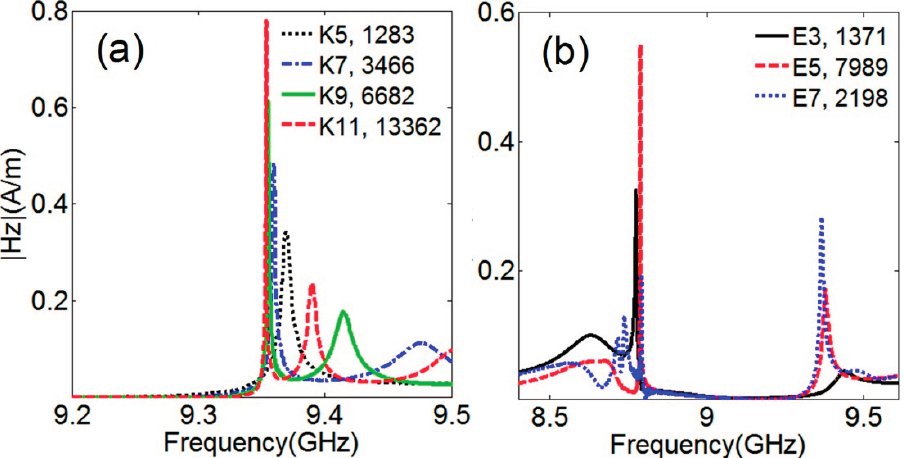
Figure 8. Fano resonances in ( a ) infinite in E-field direction arrays composed of the number of PRAs shown in insert; and ( b ) arrays composed of five PRAs with the widths restricted in E-field direction by the number of DR lines shown in insert. Q factors are shown by the second numbers in insets. DR relative permittivity is